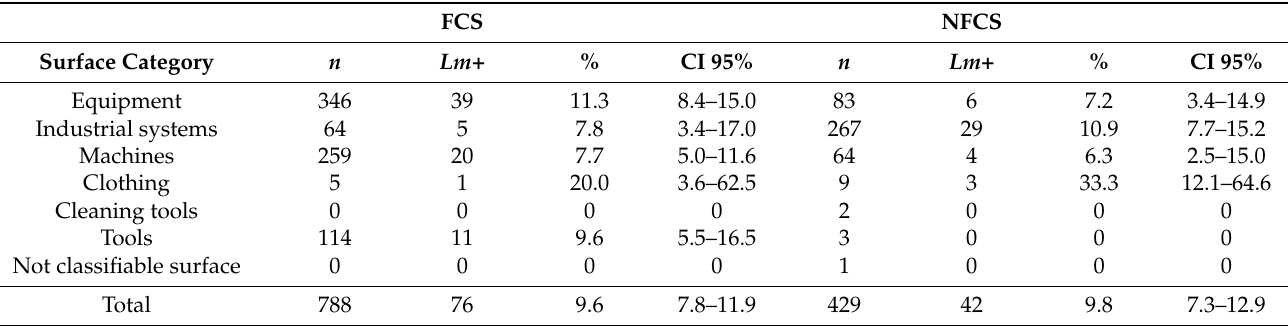
Table 2. Results of the tested FPEs based on the